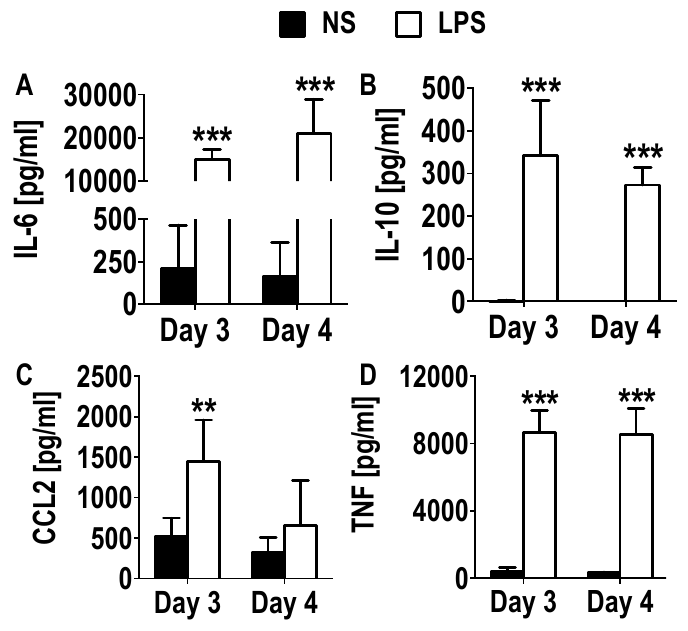
Figure 6. Cytokine section in early GM-CSF derived cultures upon LPS stimulation. Day 3 to 5 DCs generated from GM-CSF derived BM cultures were stimulated with LPS for 24 h. Culture supernatants were harvested after 24 h and CBA was used to measure the cytokine secretions within the culture, ( A ) IL-6, ( B ) IL-10, ( C ) CCL2, ( D ) TNF. Results shown are from three mice. Student’s t-Test was used to compare non-stimulated to LPS stimulated cultures. Results displayed as mean +/ − SD. ** p < 0.01, *** p < 0.001.